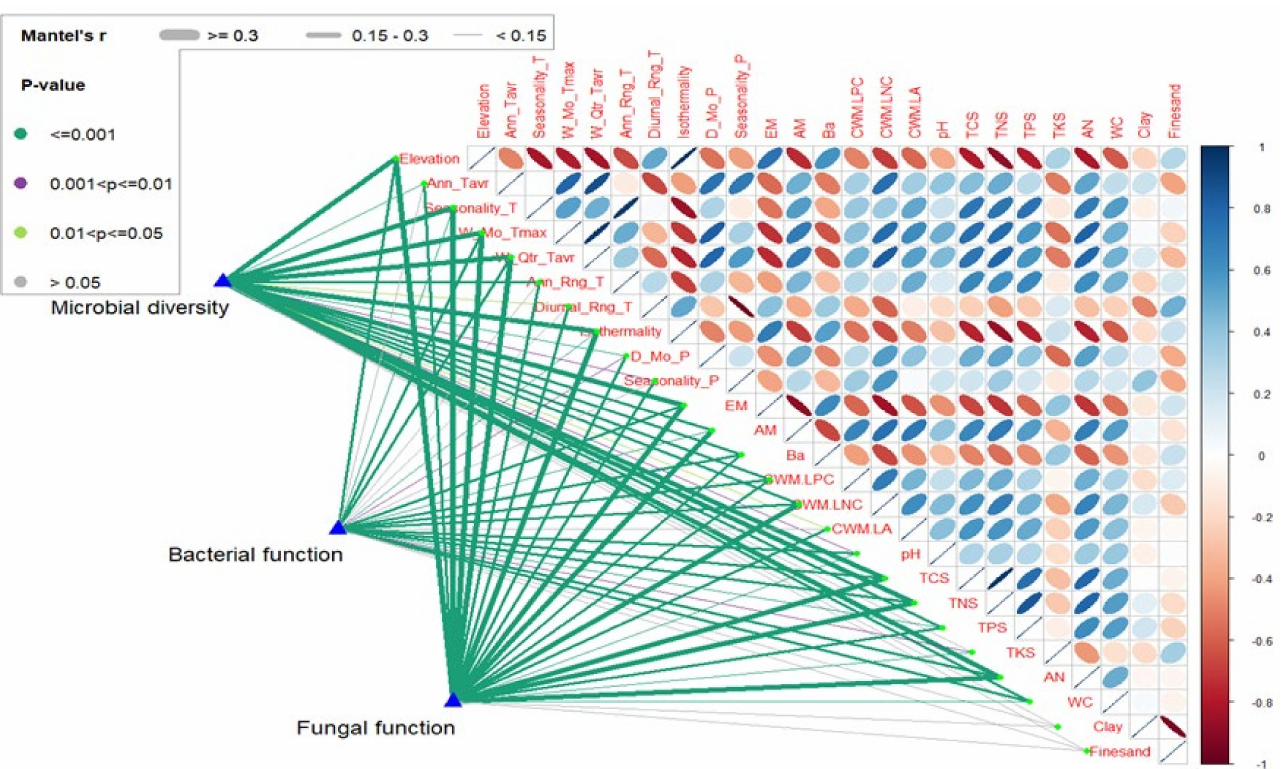
Figure 7. Relationships between environmental variables and microbial community diversity and function composition. Pairwise comparisons of environmental factors with a color gradient denote Spearman’s correlation coefficients. Microbial diversity and function composition are related to each environmental factor by the Mantel test. The environmental variables include the mean annual tem- perature (Ann_Tavr), temperature seasonality (Seasonality_T), maximum temperature of the warmest month (W_Mo_Tmax), mean temperature of the warmest quarter (W_Quart_Tavr), annual temperature range (Ann_Rng_T), mean diurnal temperature range (Diurnal_Rng_T), isothermality (isothermality, precipitation of the driest month (D_Mo_P) and precipitation seasonality